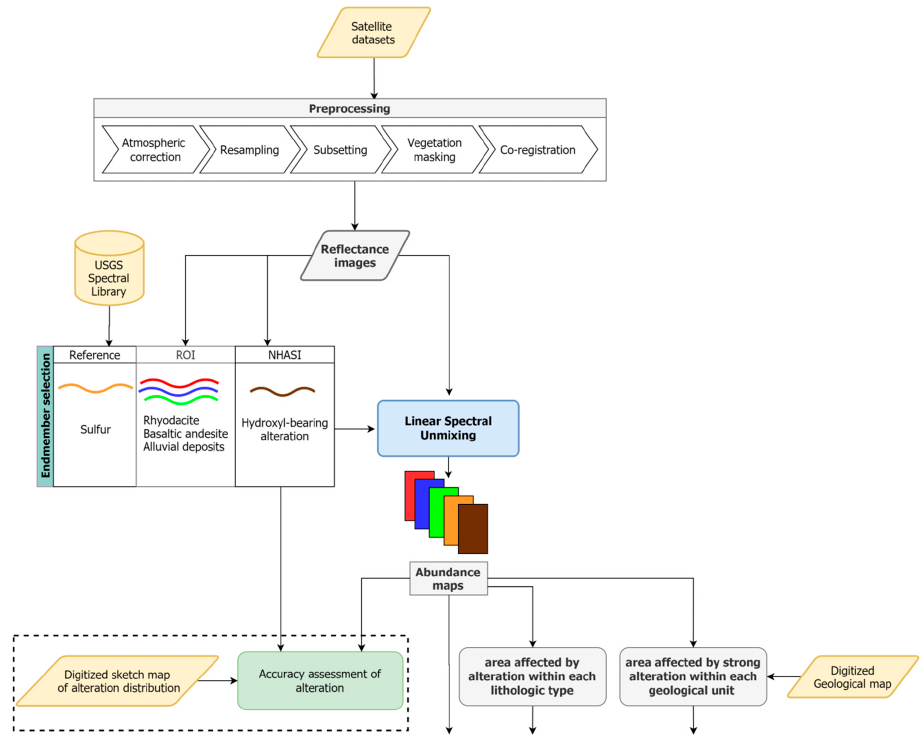
Figure 3. Flowchart of the methodology followed in this study.